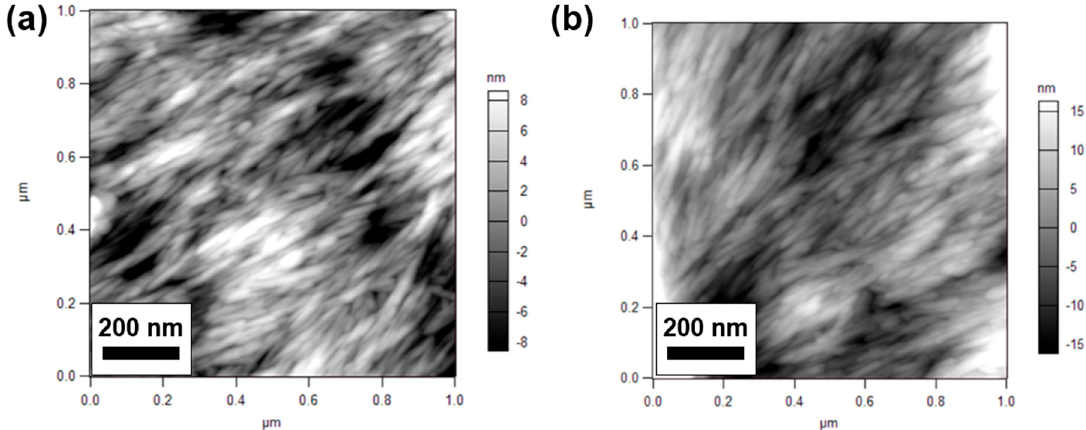
Figure 8. AFM height retrace images of ( a ) 0.5 mg TOCN loading and ( b ) 0.75 TOCN loading at the one-micron scan size (phase contrast images over the same region are included in Appendix A).